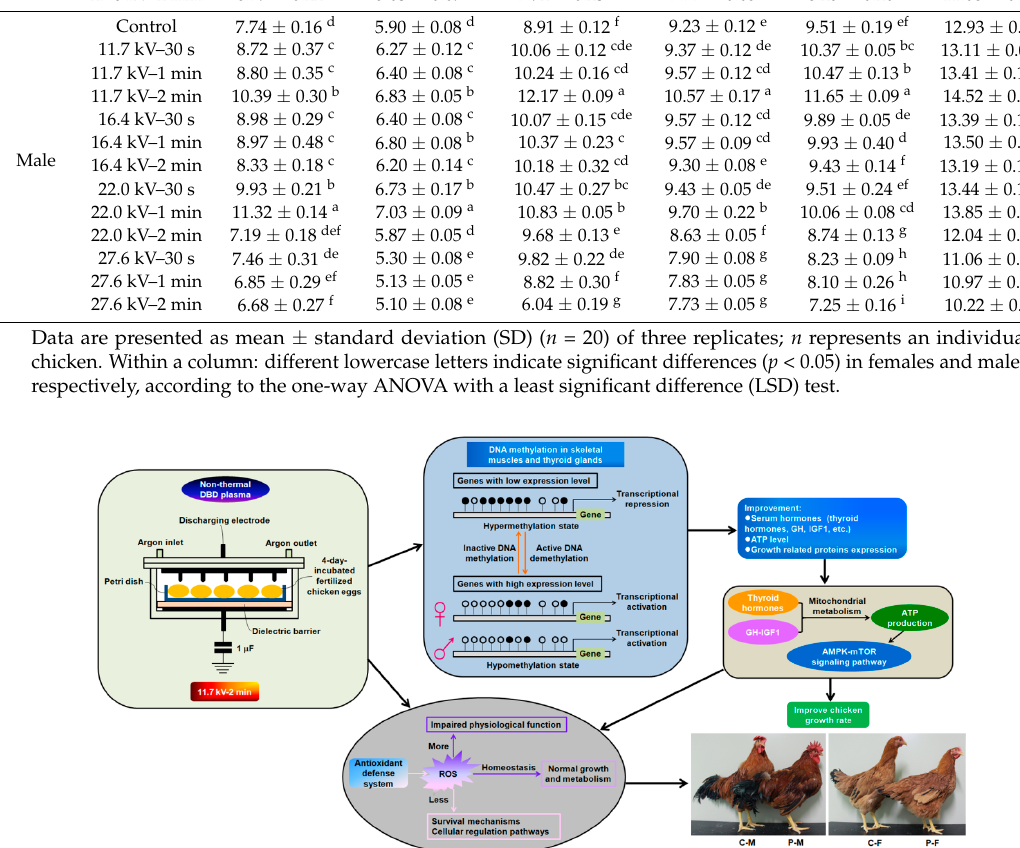
Figure 1. Description of the mechanism of how non-thermal dielectric barrier discharge (DBD) plasma affect chicken growth. The optimal plasma treatment condition is 11.7 kV for 2 min. Representative chicken growth status on day 90 is shown. C-M represents male chickens in the control group; P-M represents male chickens in the plasma treatment group. C-F represents female chickens in the control group; P-F represents female chickens in the plasma treatment group. The antioxidant defense system-mediated reactive oxygen species (ROS) homeostasis regulates the growth performance. DNA methylation in skeletal muscles and thyroid glands is involved in the regulation of chicken growth rate. ● represent methylated cytosine, and ○ represent unmethylated cytosine.